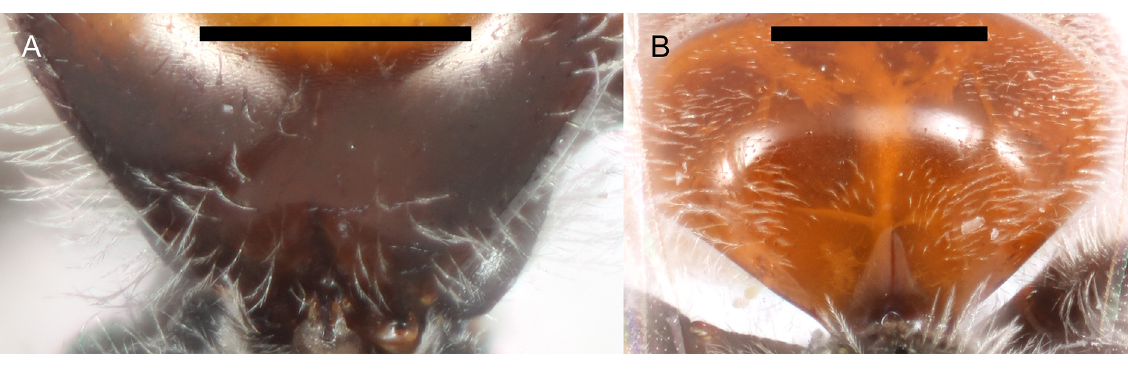
Fig. 96. T1 anterior face. A . Lasioglossum ( D. ) testaceum (Robertson, 1897), ♀, acarinarial fan absent with erect hairs throughout. B . L. ( D. ) clastipedion sp. nov., ♀, acarinarial fan present but weak, with erect hairs restricted to lateral margins. Scale bars: 0.5